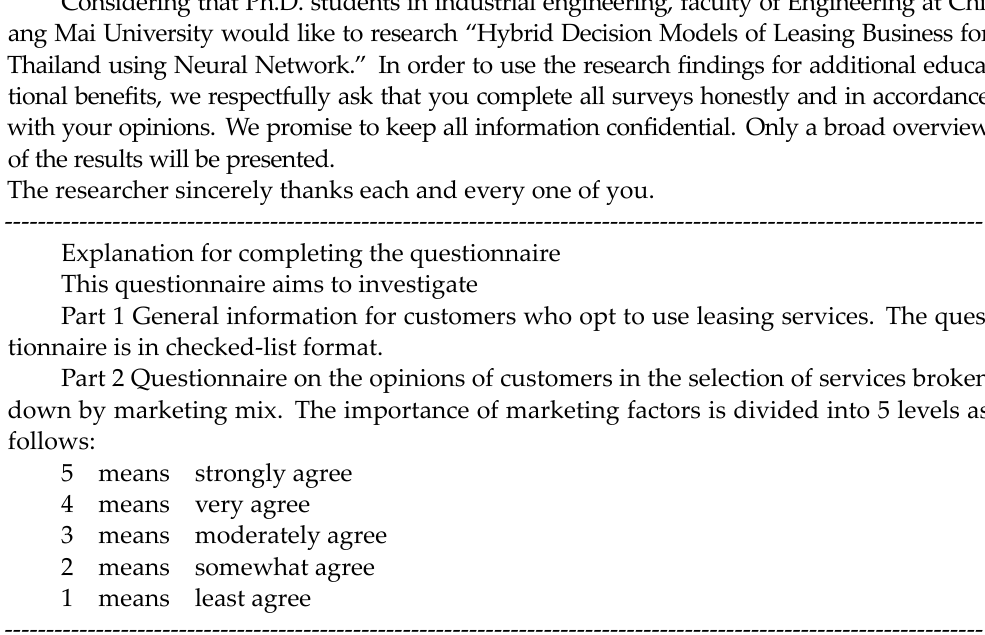
Figure A7. Structure of the NN by using cutting 50% technique model used for predicting.